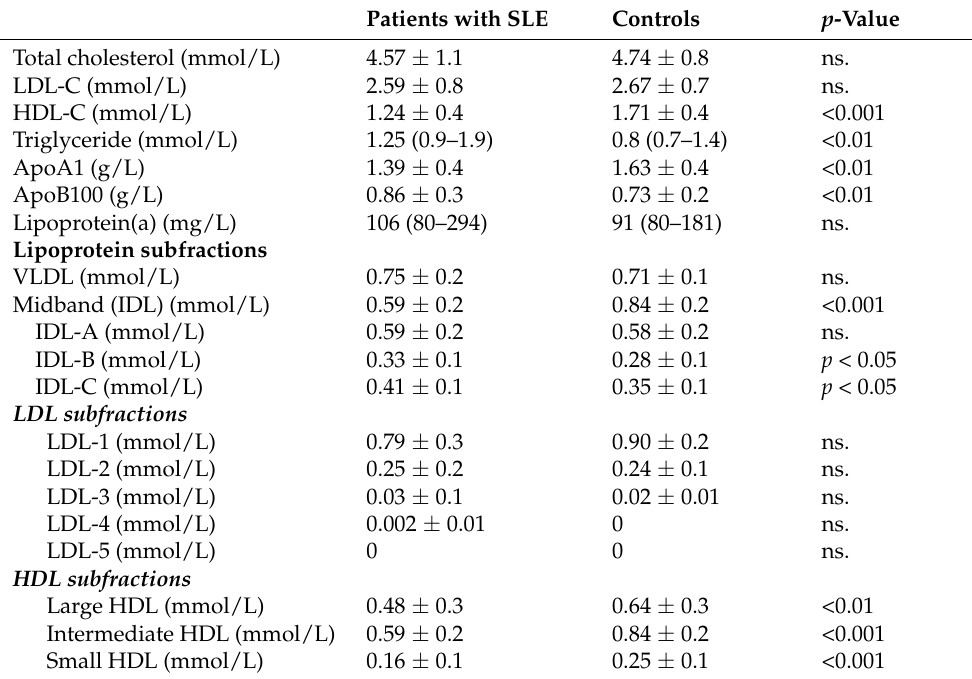
Table 2. Concentrations of lipid parameters and lipoprotein subfractions in study participants. Values are presented as mean ± standard deviation or median (lower quartile–upper quartile).